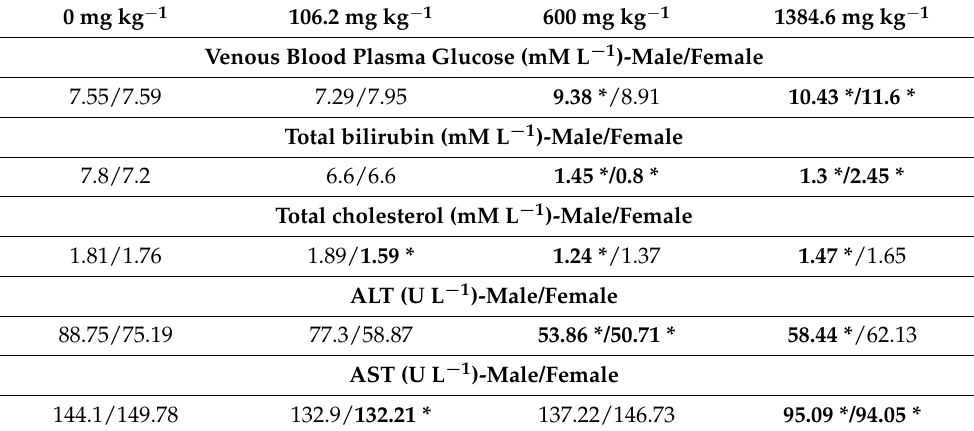
Table 2. Summary table of rats’ reliable biochemical parameters changes (in the study of acute toxicity), median values are presented. * p < 0.05 (Kruskal–Wallis one-way ANOVA